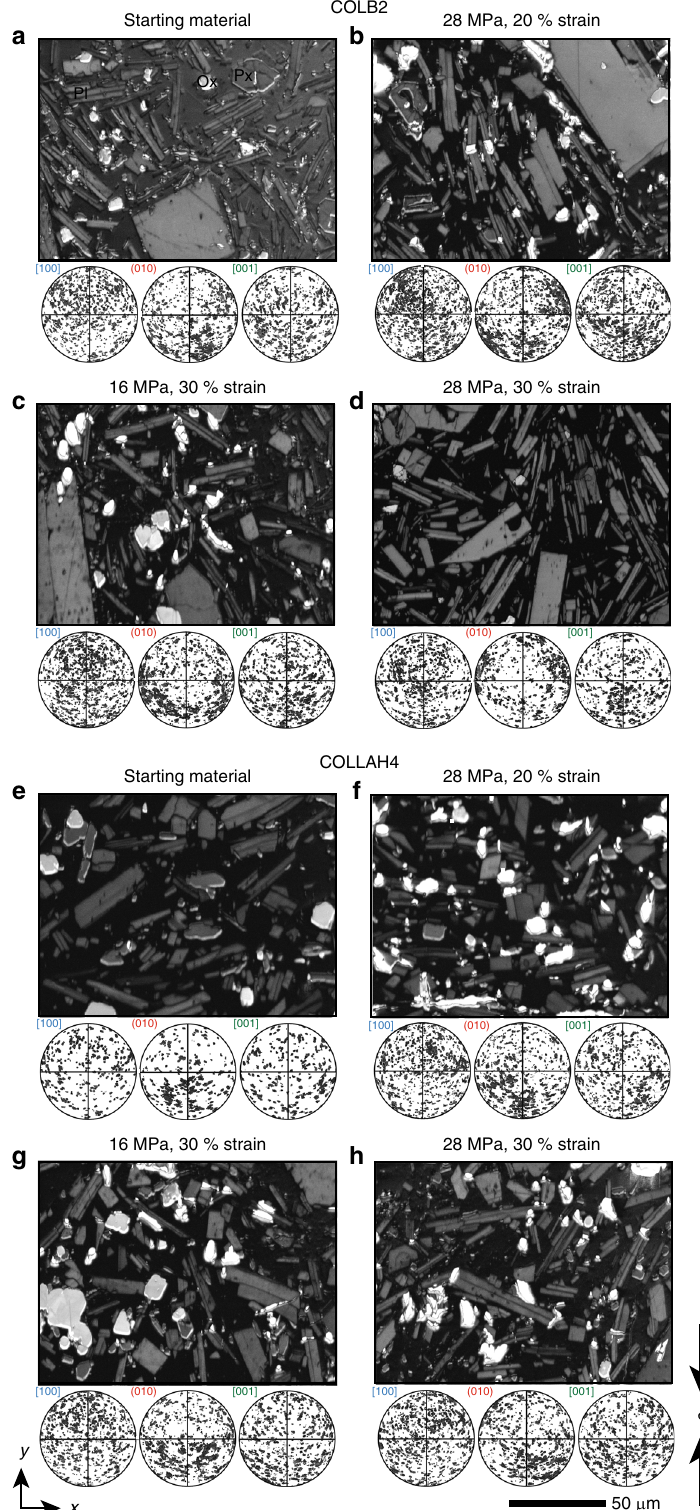
Fig. 3 Crystallographic orientation in natural and experimentally deformed andesites. Band contrast images from EBSD mapping, showing one mapped area per sample and pole fi gures [100] (010) [001] (lower hemisphere) for all microlites measured for the starting material (COLB2 in a and COLLAH4 in e ) and experimentally deformed cores (in b – d and f – h for COLB2 and COLLAH4, respectively). Scale bar is 50 μ m and refers to all panels. In the pole fi gures, local fl uctuations in crystallographic preferred orientation (CPO) are observed, but there is no apparent systematic CPO across the sample sets (all cores are cut in the same orientation, with the principal stress direction in the experimentally deformed samples vertical here). PI plagioclase, Px pyroxene, Ox iron- titanium